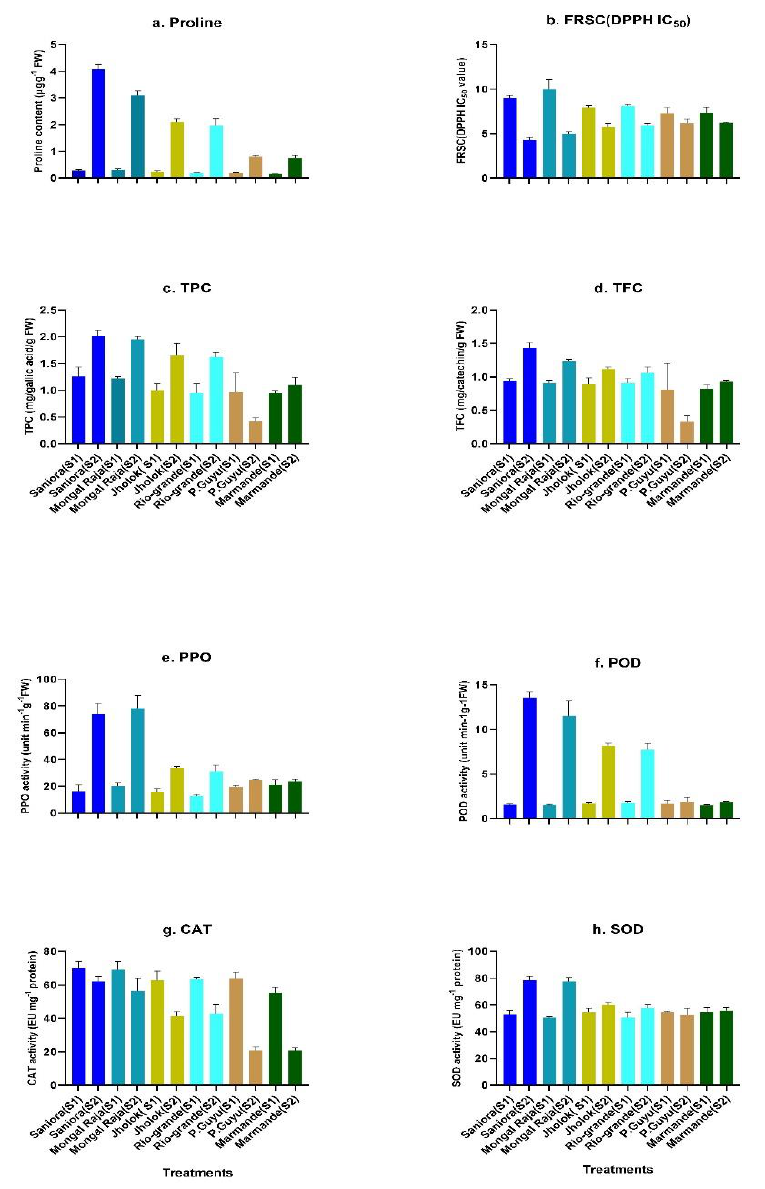
Figure 5. Biochemical parameters—( a ) proline content, ( b ) free radical scavenging capacity (FRSC) in 1,1-diphenyl-2-picrylhydrazyl (DPPH) IC 50 , ( c ) total phenol content (TPC), ( d ) total flavonoid content (TFC), ( e ) polyphenol oxidase (PPO) enzyme activity, ( f ) peroxidase (POD) enzyme activity, ( g ) catalase (CAT) enzyme activity, and ( h ) superoxide dismutase (SOD) enzyme activities of three tomato genotypes with varying tolerance levels exposed to stress treatments with S1 = control (18.2 mM NaCl) and S2 = salt (200 mM NaCl) (mean ± SD, n = 3 with three replicates; bars with similar letters are statistically identical with p ≤ 0.05).